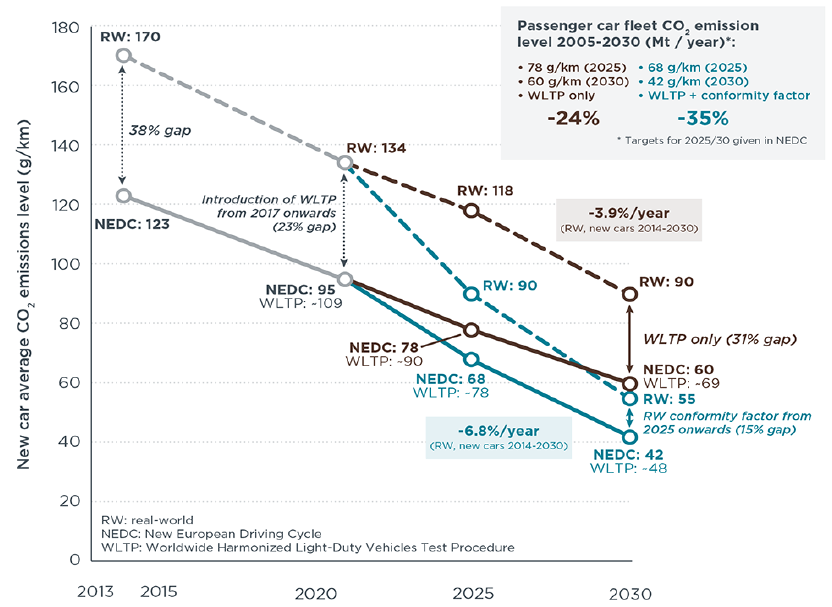
Figure 1. Projected CO 2 compliance change for type approval tests (NEDC, WLTP) and real road emissions—RW [4].